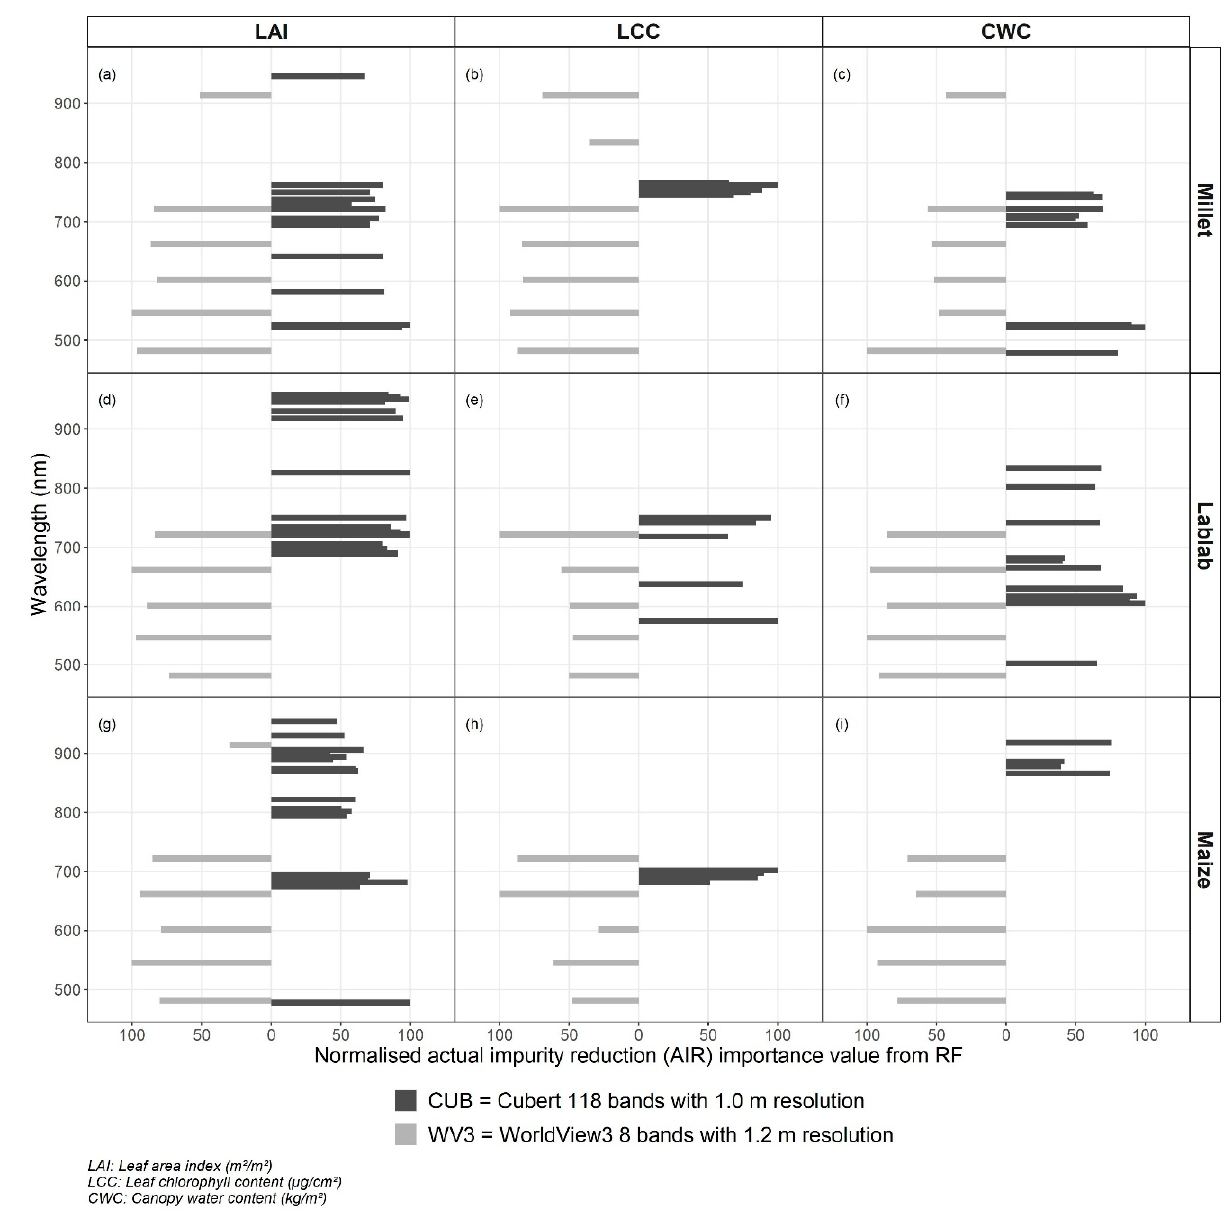
Figure A2. Distribution of actual impurity reduction value-based important wavebands for two remote sensing datasets (Cubert–black and WorldView3–grey) for leaf area index (LAI) estimation ( a , d , g ), leaf chlorophyll content (LCC) estimation ( b , e , h ), canopy water content (CWC) estimation ( c , f , i ) for finger millet ( a , b , c ), lablab ( d , e , f ), and maize ( g , h , i ) crops.